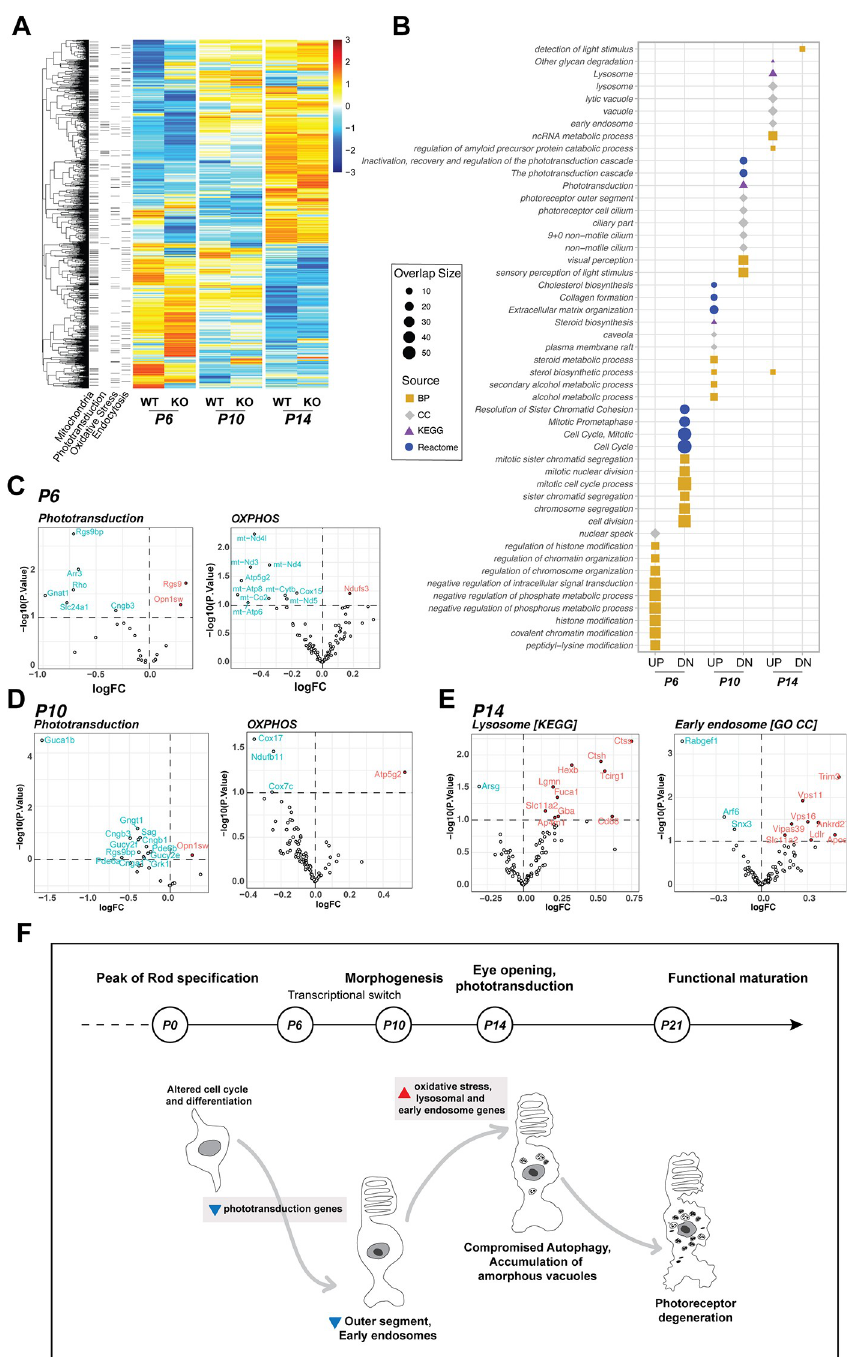
Fig 7. Transcriptomic changes in the Rabgef1 -/- retina. (A) Heatmap of differentially expressed genes in pairwise comparisons of age-matched control (WT) and Rabgef1 -/- (KO) retina. The annotation block indicates whether differentially expressed genes are part of Mitochondria (Mitocarta), Phototransduction, Oxidative stress response pathway, and/or Endocytosis pathways. (B) Functional enrichment plot of differentially expressed genes for each time point. Colored shapes represent the source of pathways or gene groups: Gene Ontology Biological Processes (BP; gold square), Gene Ontology Cellular Component (CC; grey diamond), KEGG (purple triangle), or Reactome (blue circle). Only top 10 most significant (by p-value) pathways are plotted. (C) Early changes in Rabgef1 -/- retina at P6. Volcano plots show differential expression of phototransduction and OXPHOS genes at P6, soon after rod photoreceptor birth. Red and blue labels in volcano plots denote gene over- and under- expression with significance, respectively.